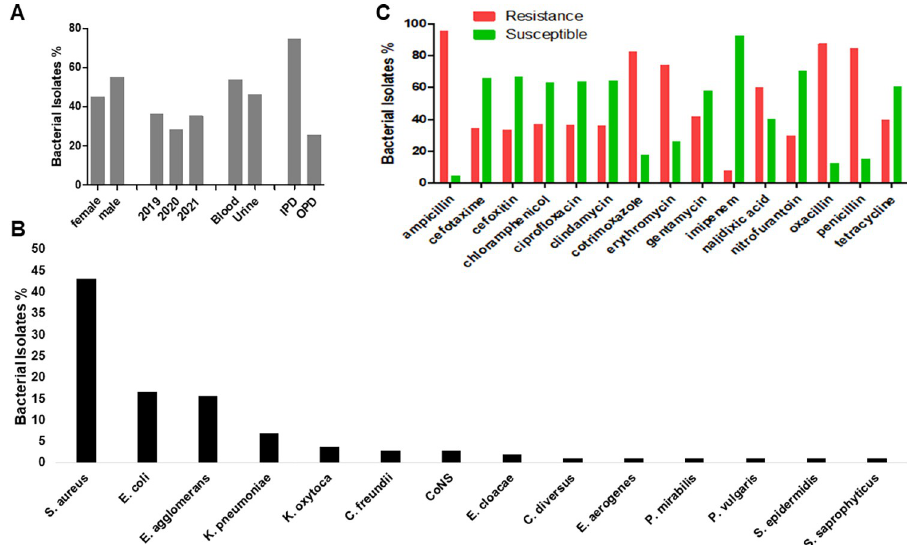
Fig 3. Characterization of bacterial isolates from paediatric specimens. (A) bacteria isolate in percentages based on patient gender, location, year of isolates, and specimen type. Blood- and uro-pathogens were the common isolates, and from IPD. (B) The common bacterial isolate (in percentages) showing the S . aureus as the most isolate and S . saprophyticus as the least isolate. (C) The susceptibility patterns (in percentages) of bacterial pathogens with imipenem, cefotaxime and nitrofurantoin retaining their potencies. IPD: in-patient department, OPD: out-patient department, CoNS: Coagulase negative Staphylococci .